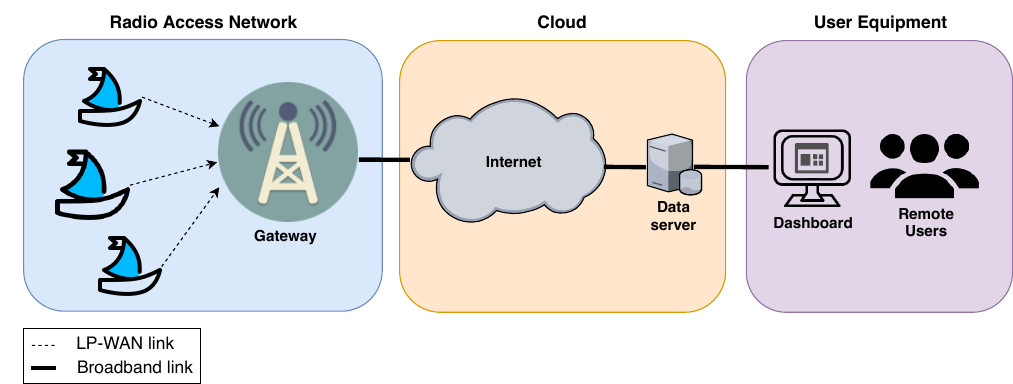
Figure 4. LP-WAN-based proposed architecture.